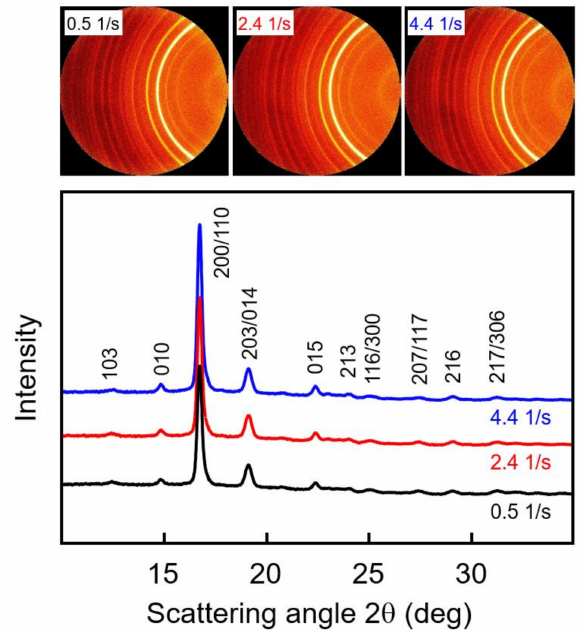
Figure 6. Two-dimensional wide-angle X-ray scattering (WAXS) patterns of PLLA with a molar mass of 70 kg/mol, acquired at different radius positions of 0.4, 1.9, and 3.5 mm of a crystallized disc sheared at 135 ◦ C for 10 s with a rate of 5 1/s ( top ), and azimuthally averaged intensity as a function of the scattering angle 2 θ ( bottom ). Diffraction peaks were indexed based on information available in the literature